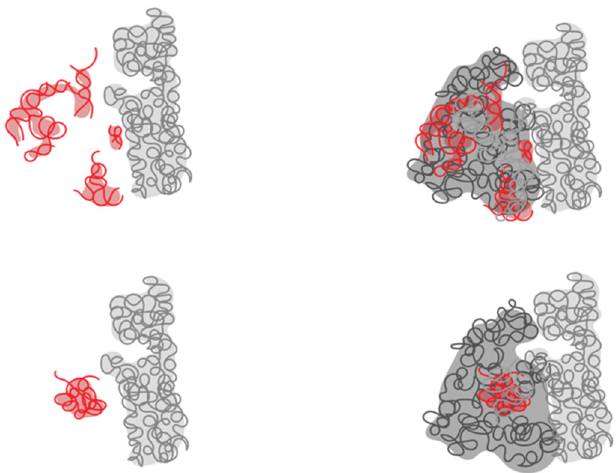
Figure 3. Abstraction of the ribosome showing discrepancies in defining the most ancestral part of the ribosome. According to the consensus (bottom), the most ancestral part is the PTC (in red), while according to Caetano ‐ Anoles, the most ancestral part is in the processivity region (in red, top).